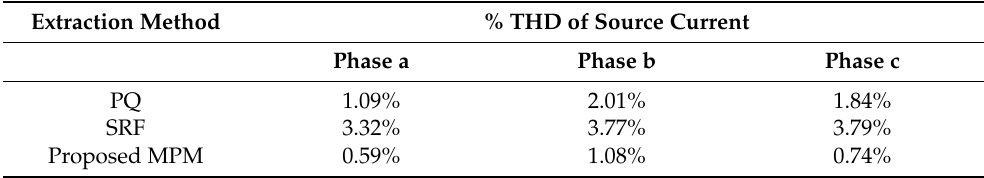
Figure 13. Waveforms and DC-link voltage under asymmetrical load conditions using MPM tech- nique.